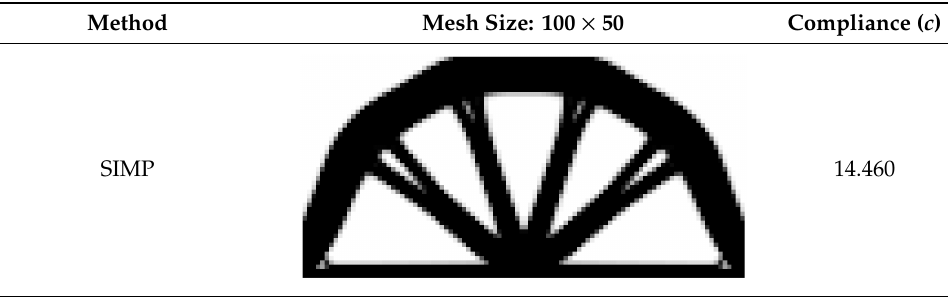
Figure 7. Problem definition of the pinned-roller plate: design domain, loading, and supports.